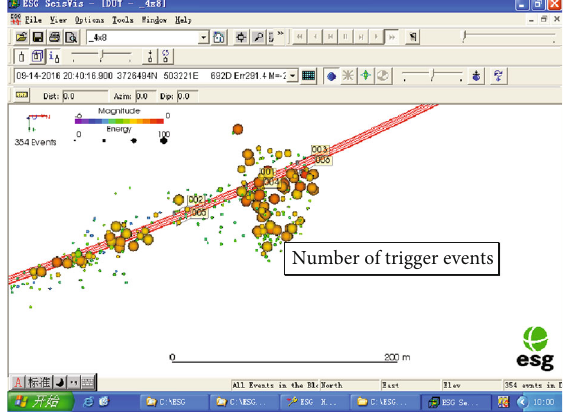
Figure 26: SeisVis interface fi gure.